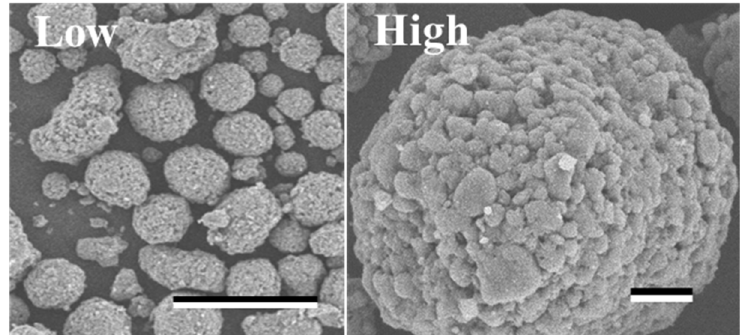
Figure 2. SEM image of the carbon materials. Scale-bars were 100 µm and 10 µm under low (×350) and high (×1600) magnifications.